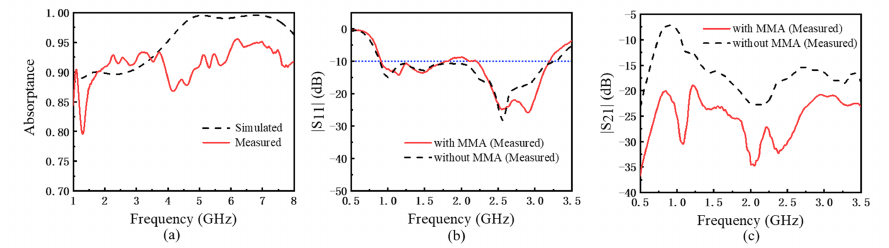
Figure 11. ( a ) The measured absorptance of MMA. The measured ( b ) | S 11 | and ( c ) | S 21 | of the proposed antenna with MMA and without MMA.